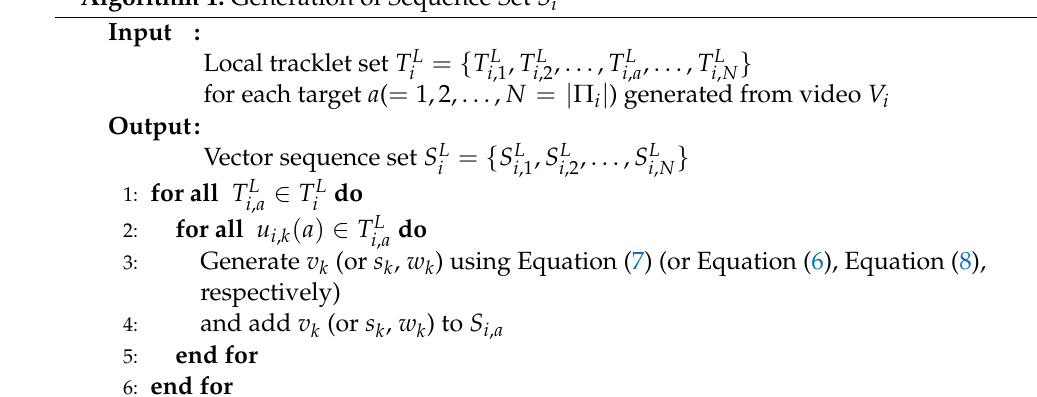
Algorithm 1: Generation of Sequence Set S i